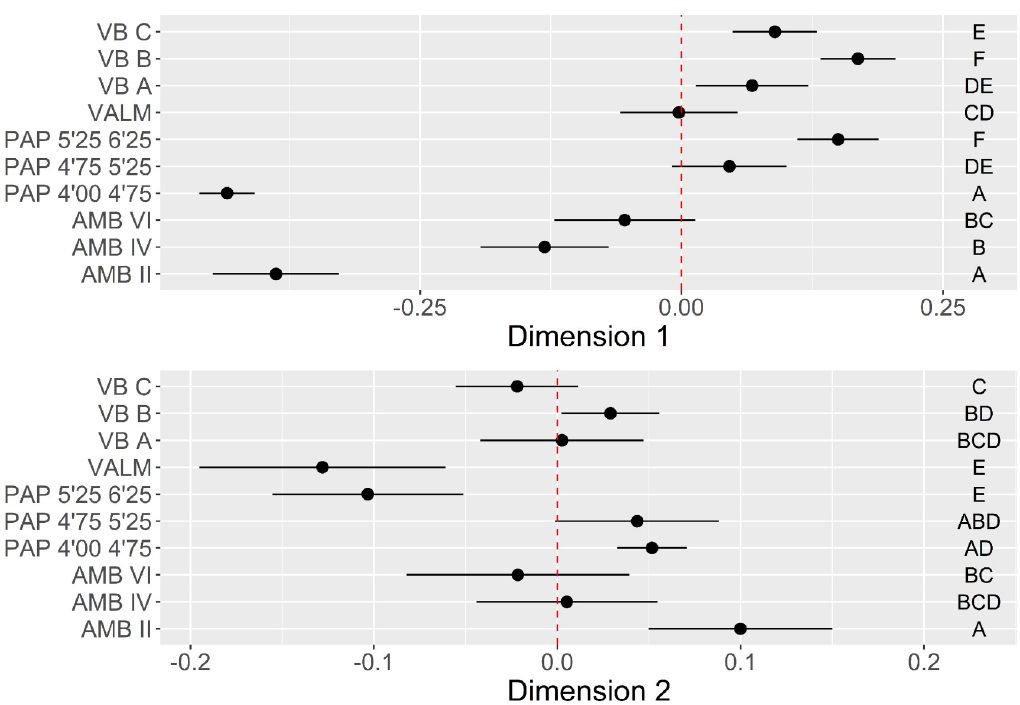
Fig 6. Platform maintenance multi-comparison bootstrap ANOVA. Error bars represent 95% confidence interval from the mean. Contexts sharing the same set of letters do not present statistically significant difference (p-value � 0.05).